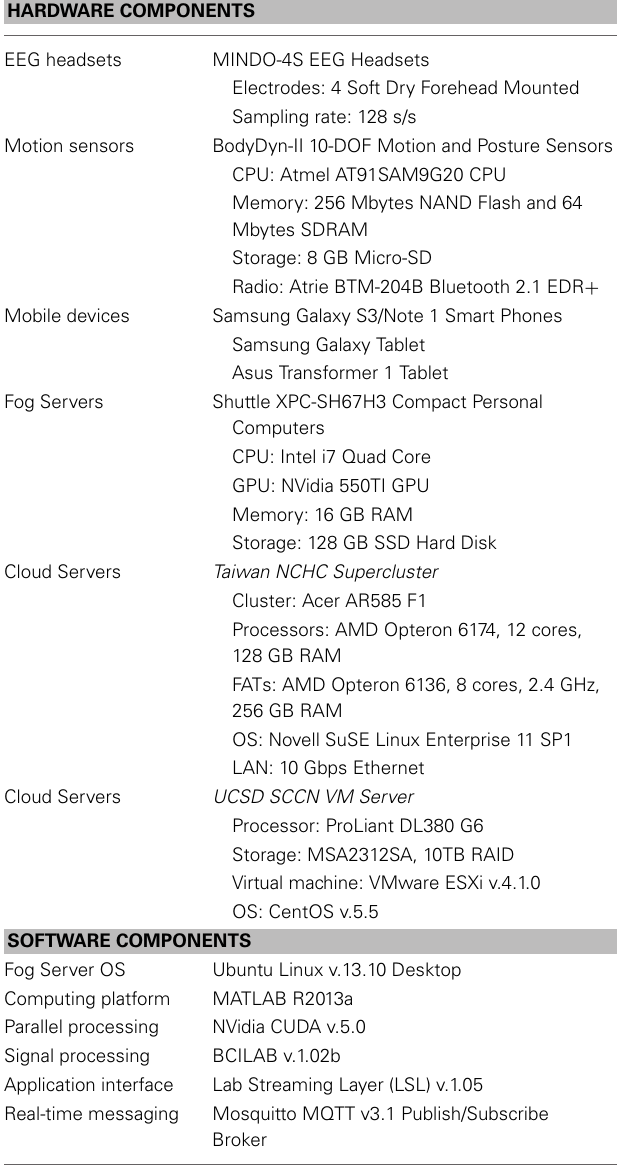
Table 1 | Hardware and software components for the pervasive on-line EEG-BCI pilot